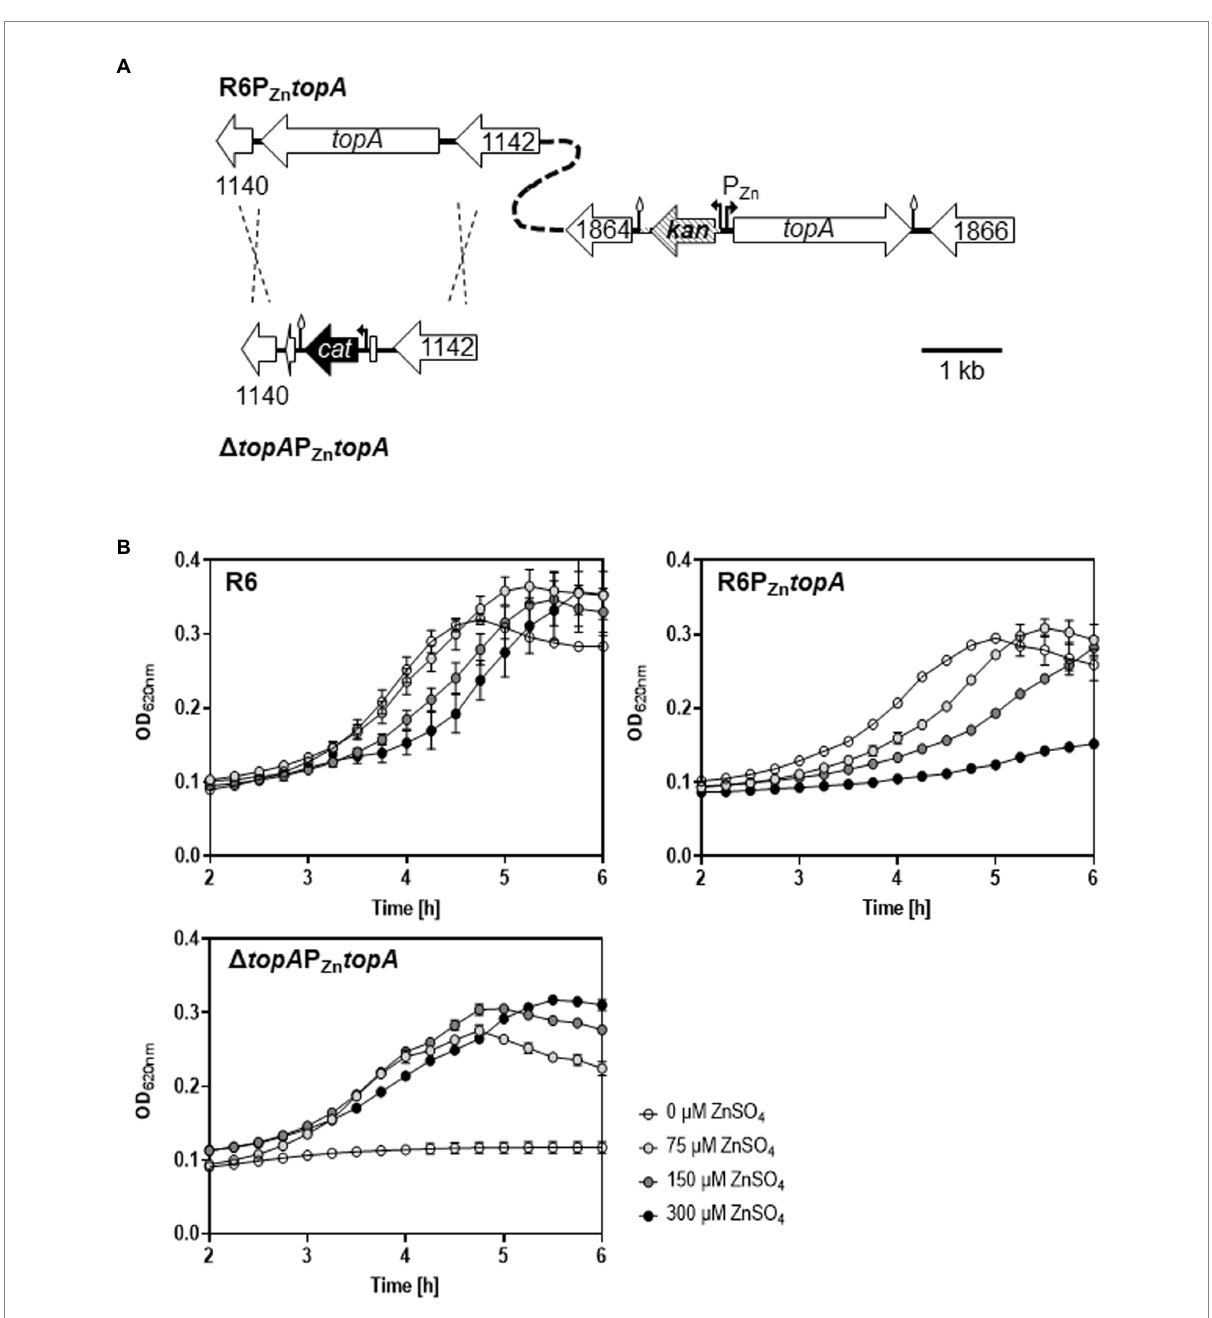
FIGURE 1 Levels of TopoI affect growth. (A) Representation of the genetic structure of the R6-derivative strains with respect the location of the topA gene. (B) Growth of the indicated strains monitored in a TECAN Infinite 200 PRO reader. Strains were grown to OD 620nm = 0.4 in medium containing 75 μ M ZnSO 4 and diluted 100-fold in medium containing the indicated amounts of ZnSO 4